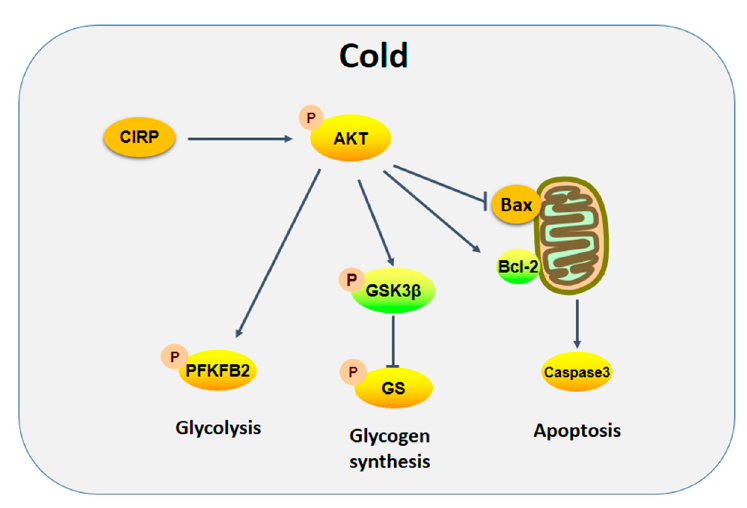
Figure 10. A proposed model for the molecular mechanisms of acute cold stress in the liver. Arrows express promotion, T-bar represent inhibition.